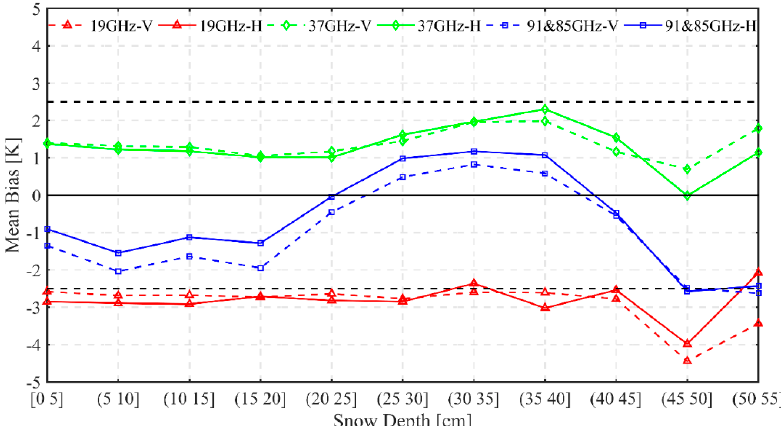
Figure 12. The sensitivity of the brightness temperature di ff erence between SSM / I and SSMIS to the snow depth. Solid and dotted lines represent mean bias for horizontal (H) and vertical (V) polarizations, respectively.